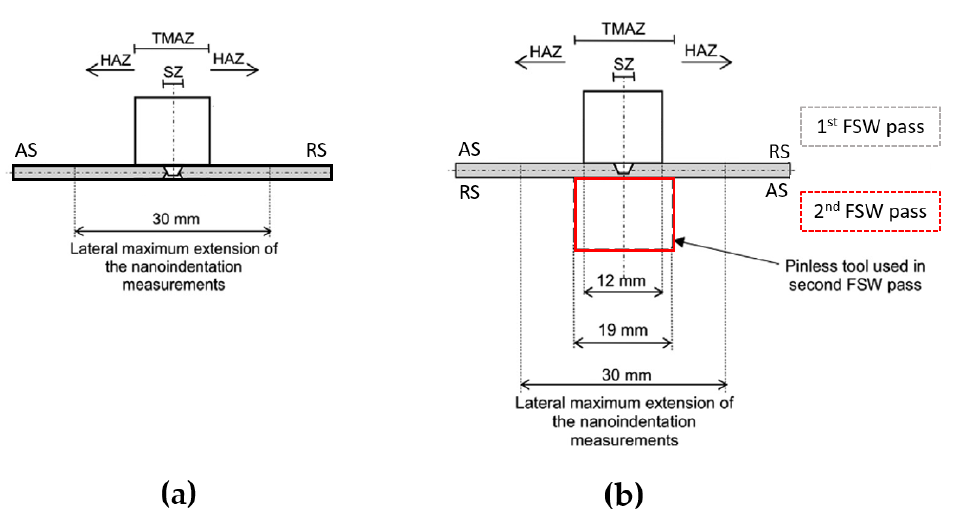
PINLESS TOOL PINLESS TOOL